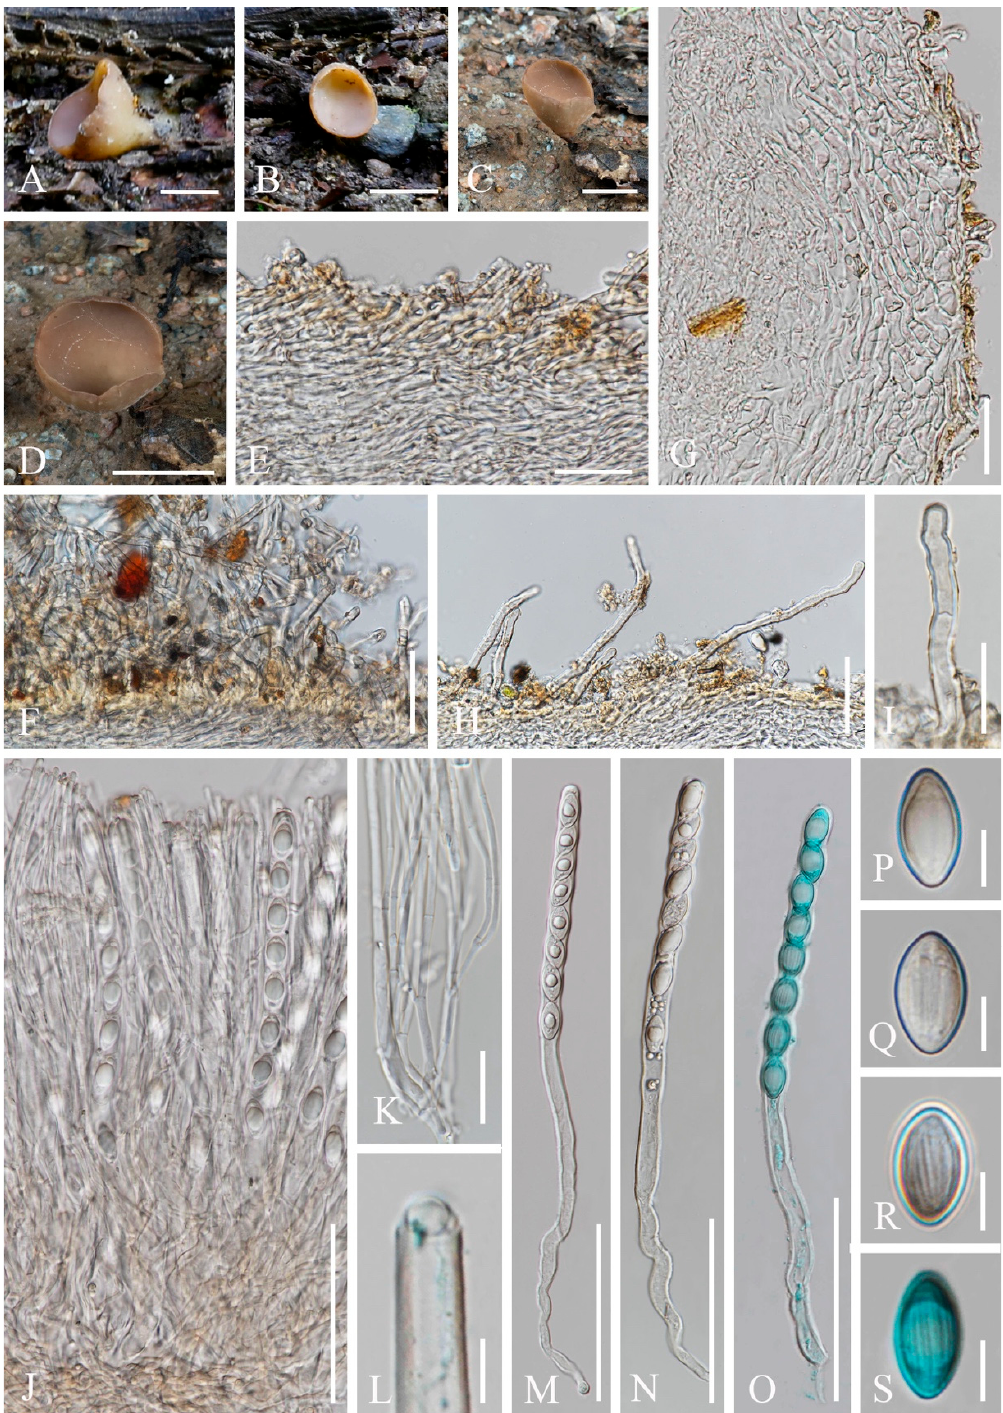
Figure 19. Sarcoscypha longitudinalis . ( A – D ) Fresh specimens [( A , B ) HKAS 121196. ( C , D ) HKAS 121195.] ( E ) Vertical section of stipe ectal excipulum. ( F ) Hyphoid hairs on the base. ( G ) Vertical section of receptacle ectal excipulum. ( H , I ) Hyphoid hairs from receptacle ectal excipulum. ( J ) Hymenium. ( K ) Paraphyses. ( L ) Apex of ascus. ( M – O ) Asci and ascospores [( O ) Ascus and ascospores in CB.] ( P – S ) Ascospores [( S ) Ascospore in CB.] Scale bars ( A ) = 1 cm; ( B – D ) = 2 cm; ( E , G ) = 30 μ m; ( F , H ) = 50 μ m; ( I , K ) = 20 μ m; ( J , M – O ) = 100 μ m; ( L , P – S ) = 10 μ m.